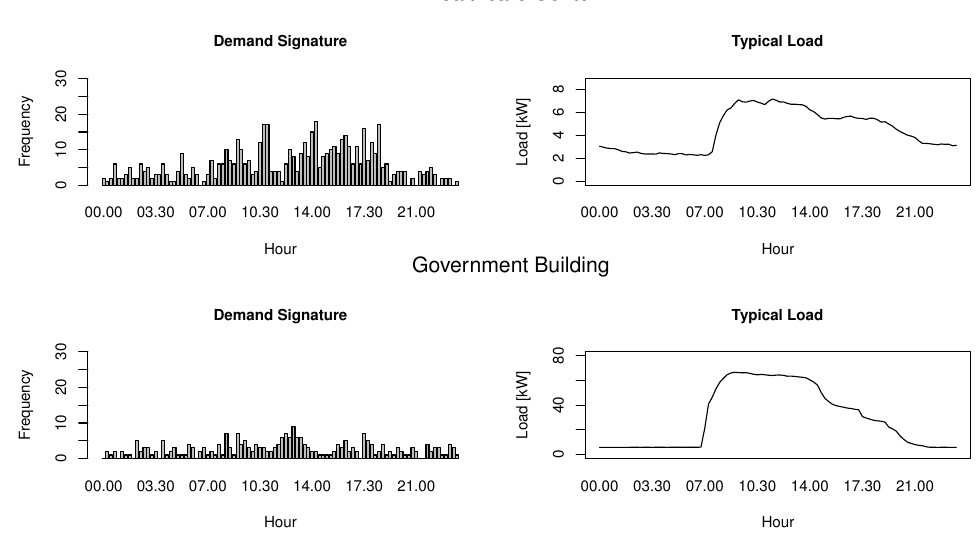
Figure 4. Demand signature vs. characteristic typical load curve for two